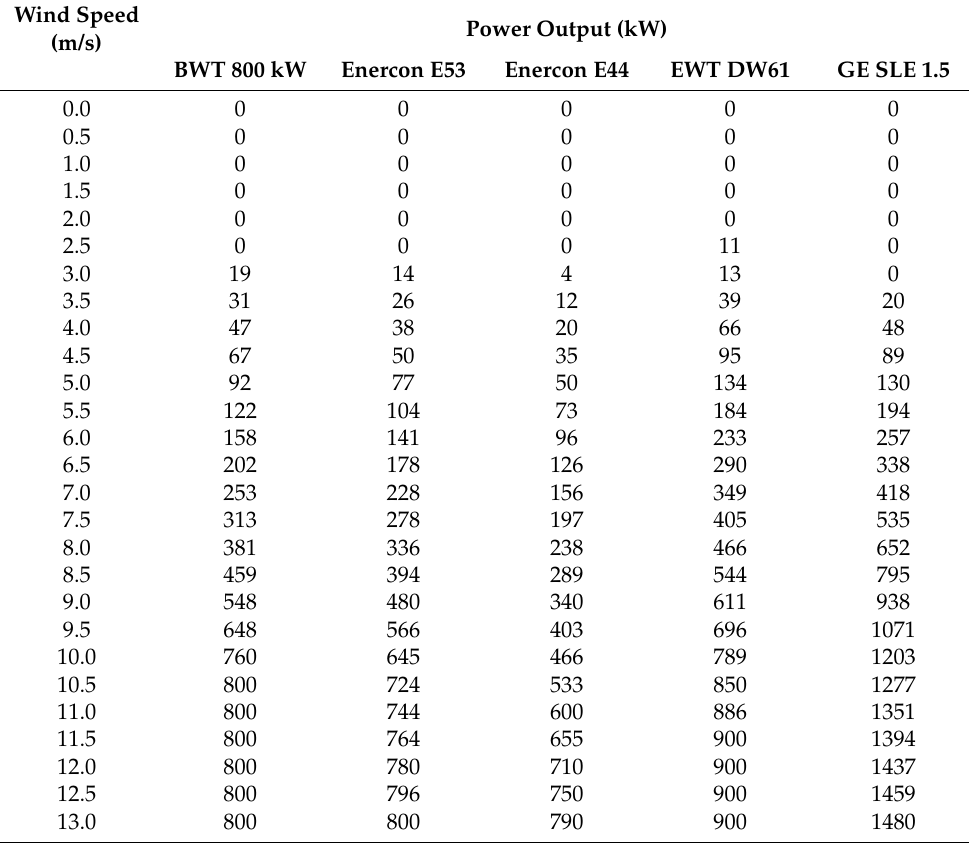
Table A1. Power curves of the BWT and the exiting commercial wind turbines compared. Wind